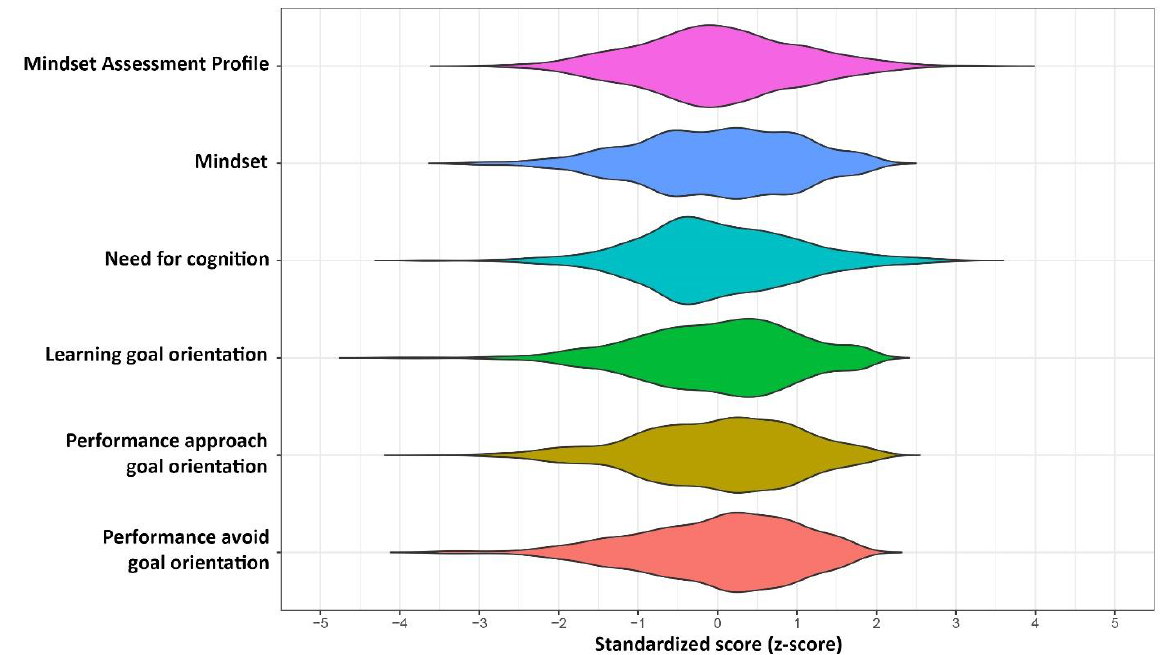
Figure 1. Distribution of standardized scores (i.e., z -scores) on each measure. Note: “Mindset” refers to the Implicit Theories of Intelligence Questionnaire.